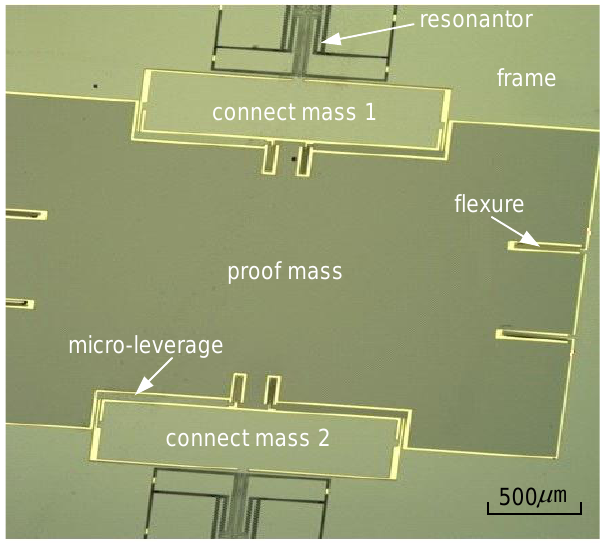
Figure 4. SEM photo of the mechanical sensitive structure.